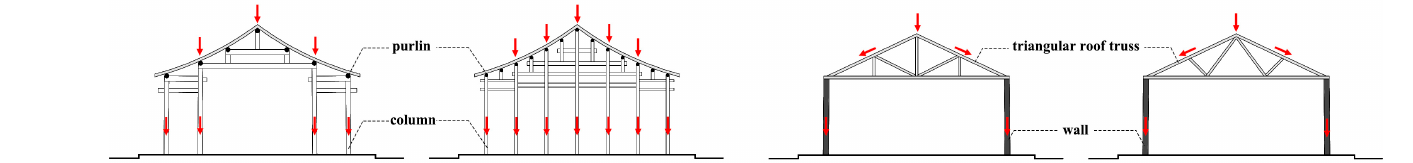
Figure 1. A comparison of typical Chinese traditional and wghhj43iestern roof structures. Pictures by X.X.